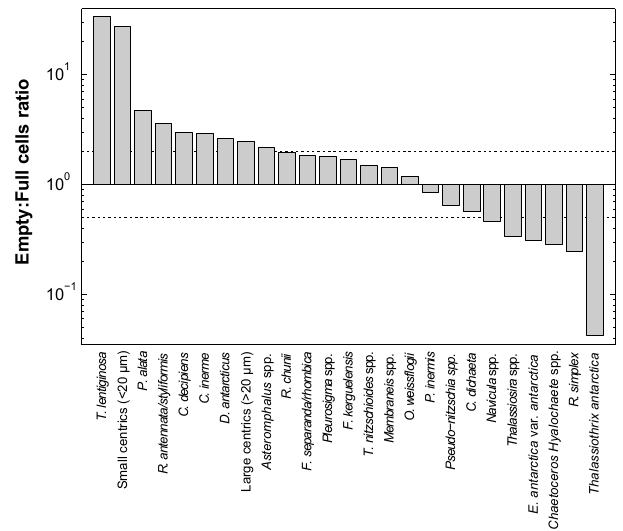
Figure 4. Annual ratio of empty to full cells for species observed as both forms. The dashed lines are the 0.5 and 2 ratio values. Chaetoceros Hyalochaete spp. full cells were only observed as rest- ing